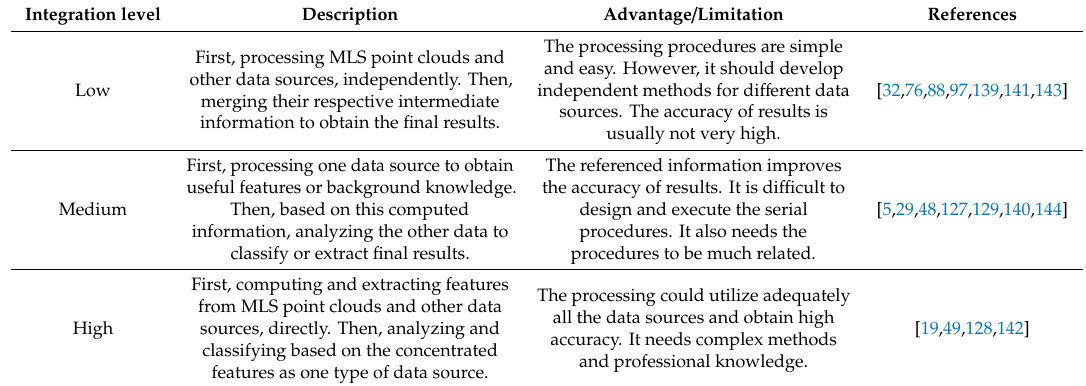
Table 2. The overview of the data integration framework of MLS point clouds with other data